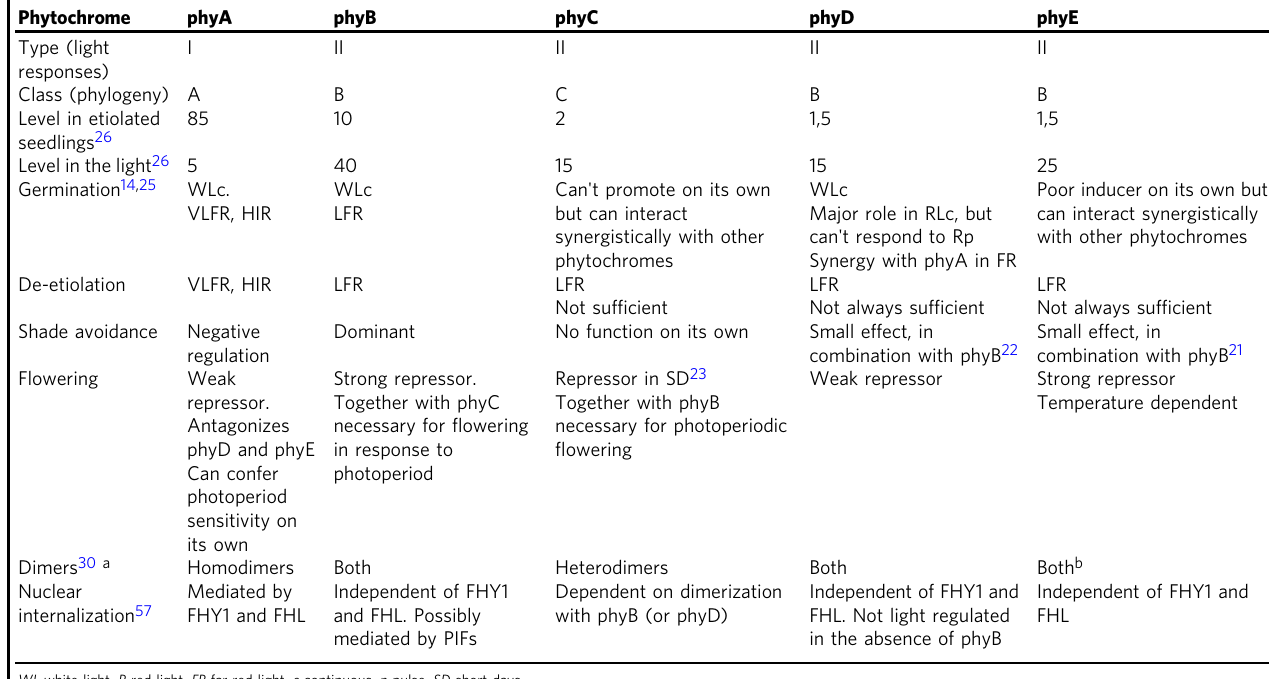
Table 1 Functional diversi fi cation of the phytochrome family in Arabidopsis